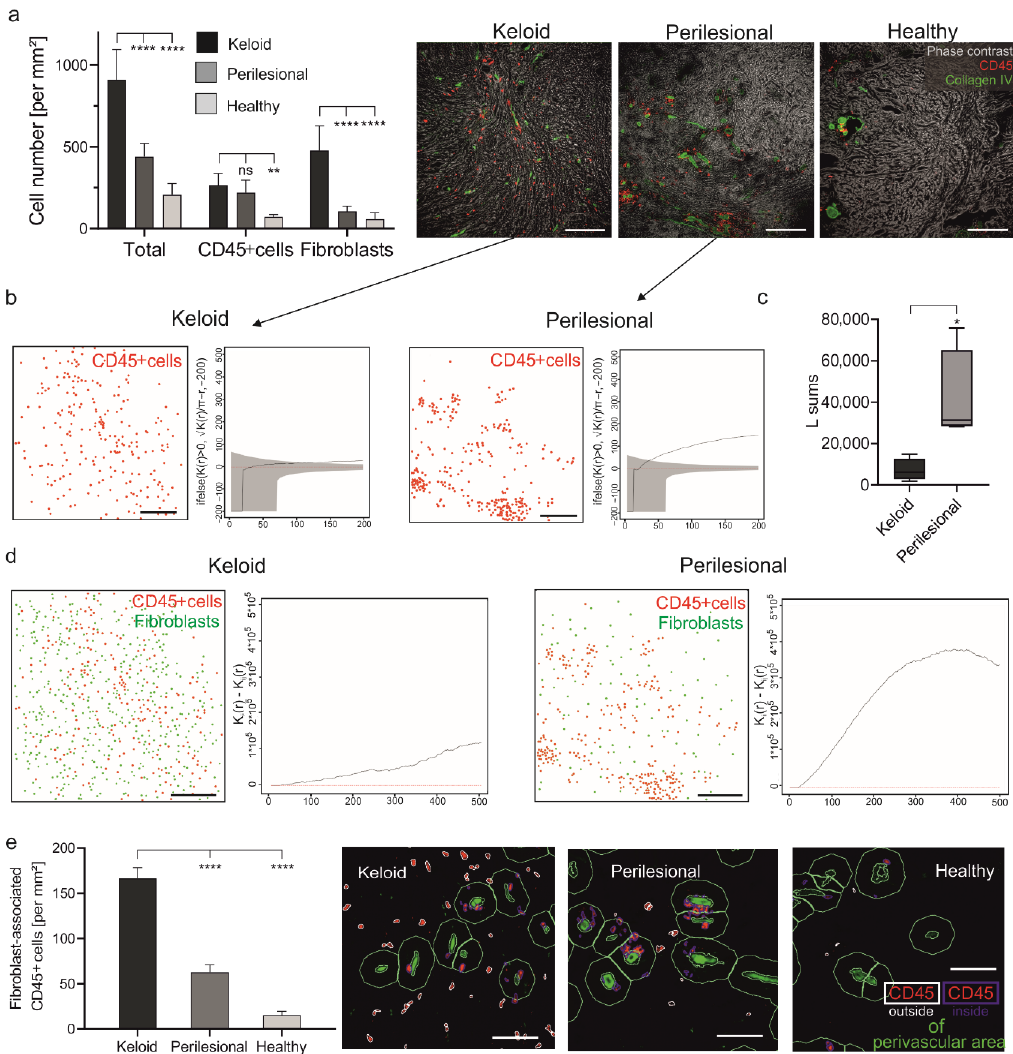
Figure 1. The increased number of fibroblast-associated leukocytes in keloid. ( a ) Skin sections of keloid, perilesional and control tissue were subjected to an MAA analysis, and the number of total cells and CD45+ cells were quantified (left panel). Representative images showing an overlay of phase contrast (grey) and CD45+ cells (red) in addition to blood vessels (collagen type IV, green) (right panel). Scale bars = 200 µ m; Data are means ± SEM from n patients ( n (Keloid) = 8, n (perilesional) = 8, n (control) = 5). Statistical significance was assessed based on the p value (ns p > 0.5, ** p < 0.01, **** p < 0.0001) and determined using, two-way ANOVA and Dunnett’s test. ( b ) Characterization of the spatial distribution of CD45+ cells (red) across analyzed keloid ( n = 4) and perilesional ( n = 4) tissue samples. Besag’s L function (solid black line) and acceptance envelope (grey), which give the range of L values for which the cell distribution is not significantly different from complete spatial randomness (red dotted line). For the keloid sample, Besag’s L function is either engulfed